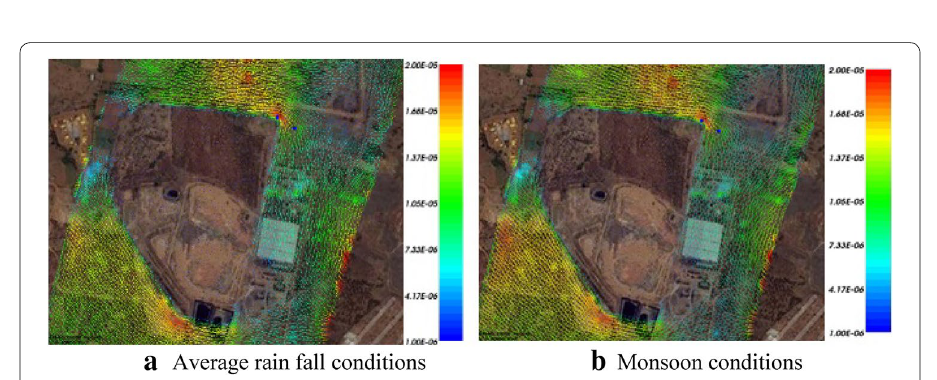
Fig. 11 Groundwater velocity vector plots in the sandy soil